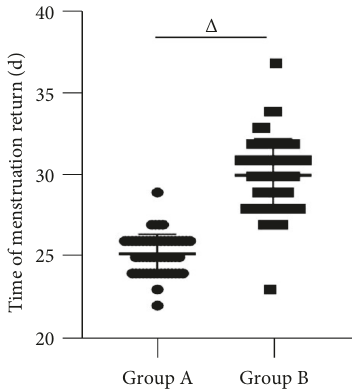
Figure 6: Endometrial